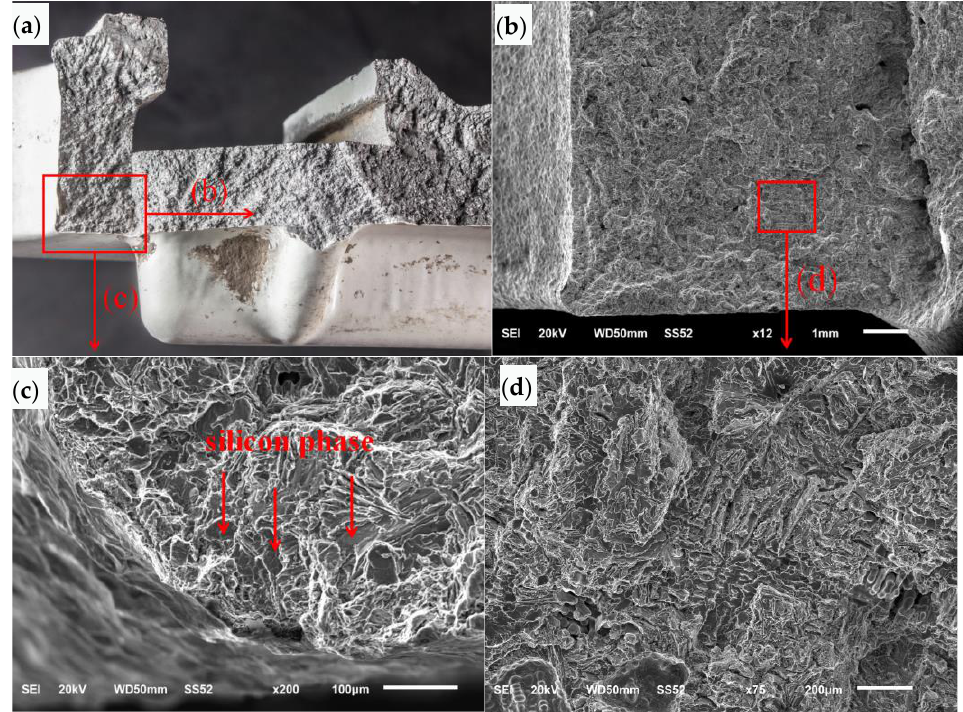
Figure 7. SEM morphology of crack initiation zone: ( a ) fracture surface, ( b ) low magnification, ( c ) high magnification, ( d ) local area of the crack surface.